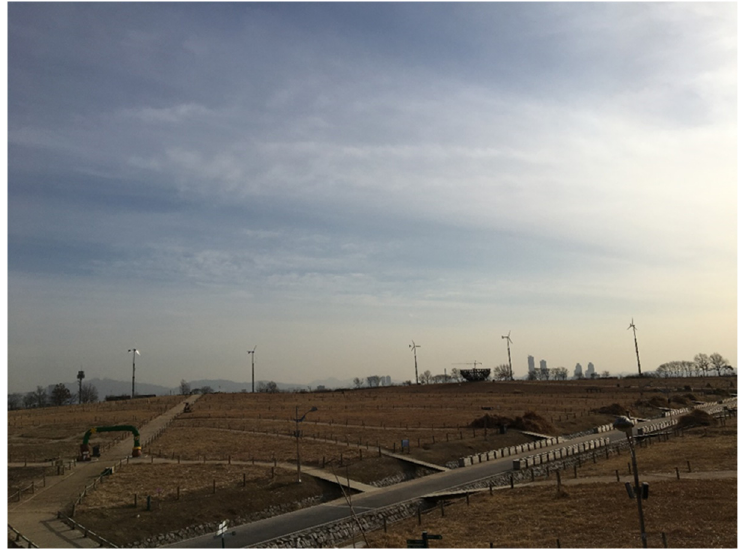
Figure 4. View overlooking Haneul Park. Source: Author’s photograph.